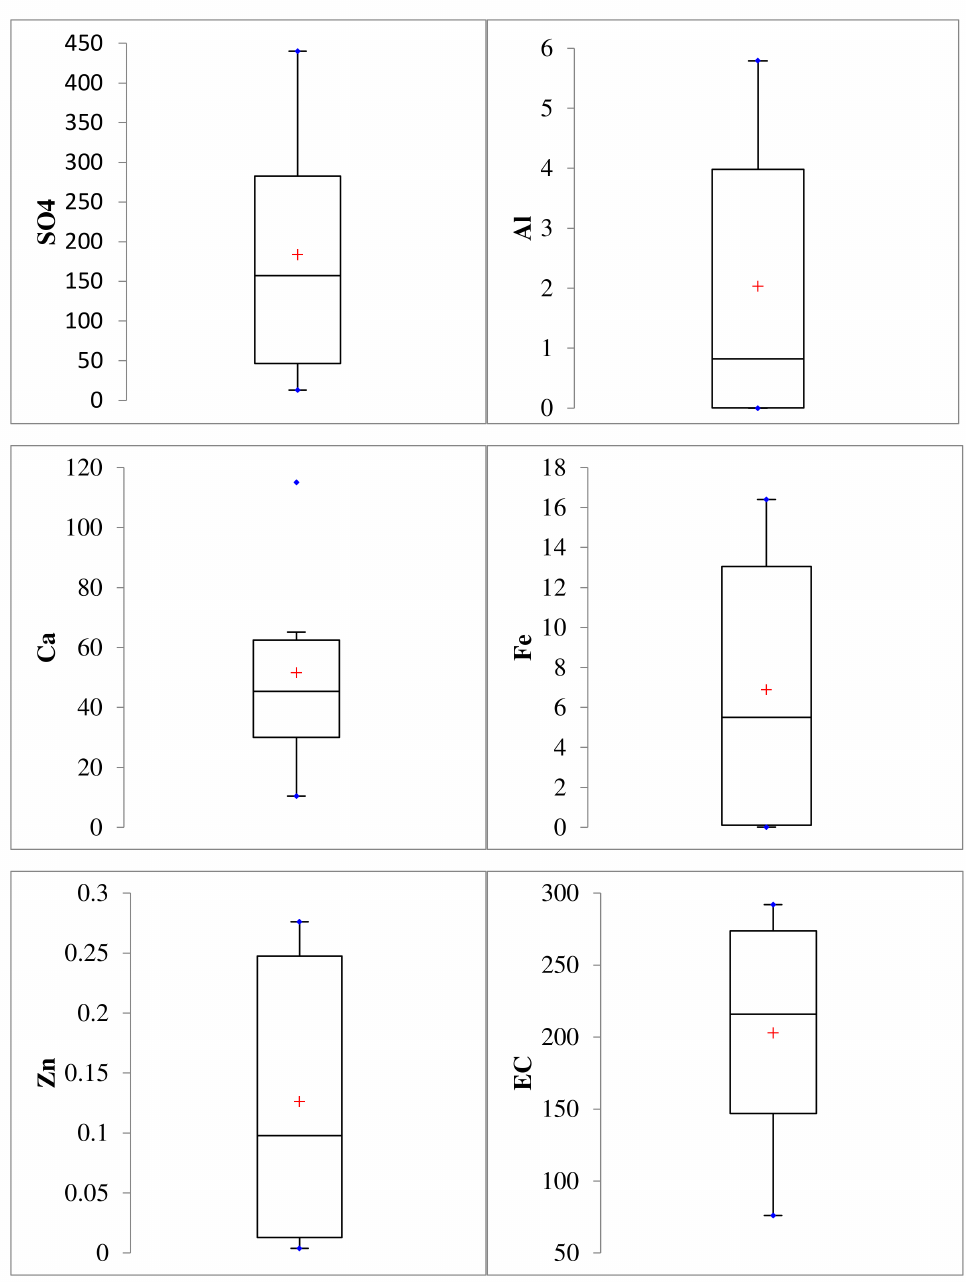
Figure 10. Distribution of major components in sampled water collected during last